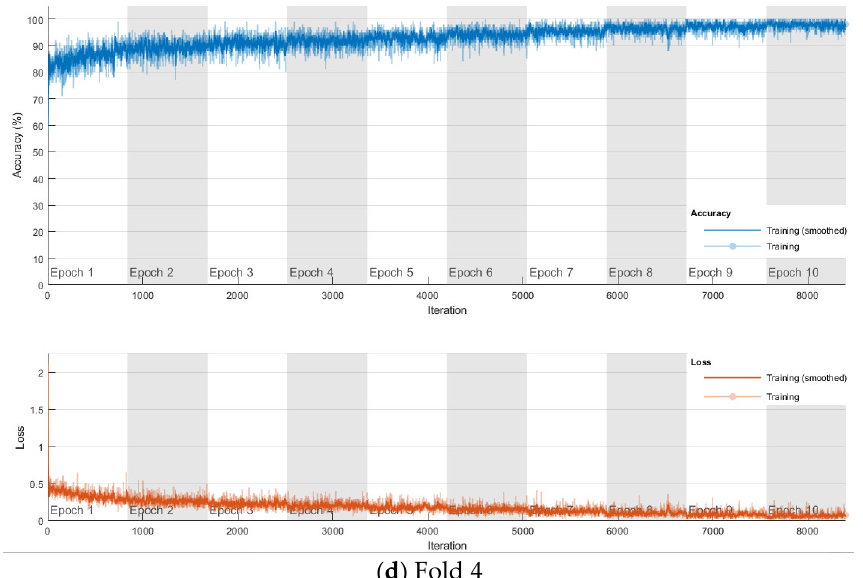
Figure 7. Training progress of the 4-fold cross-validation of the softmax classifier-based model on breast cancer dataset.